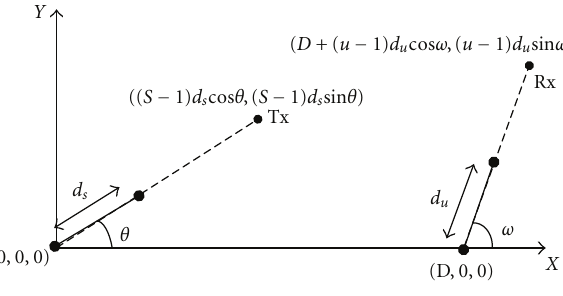
Figure 3: Positioning of the elements in a U × S MIMO